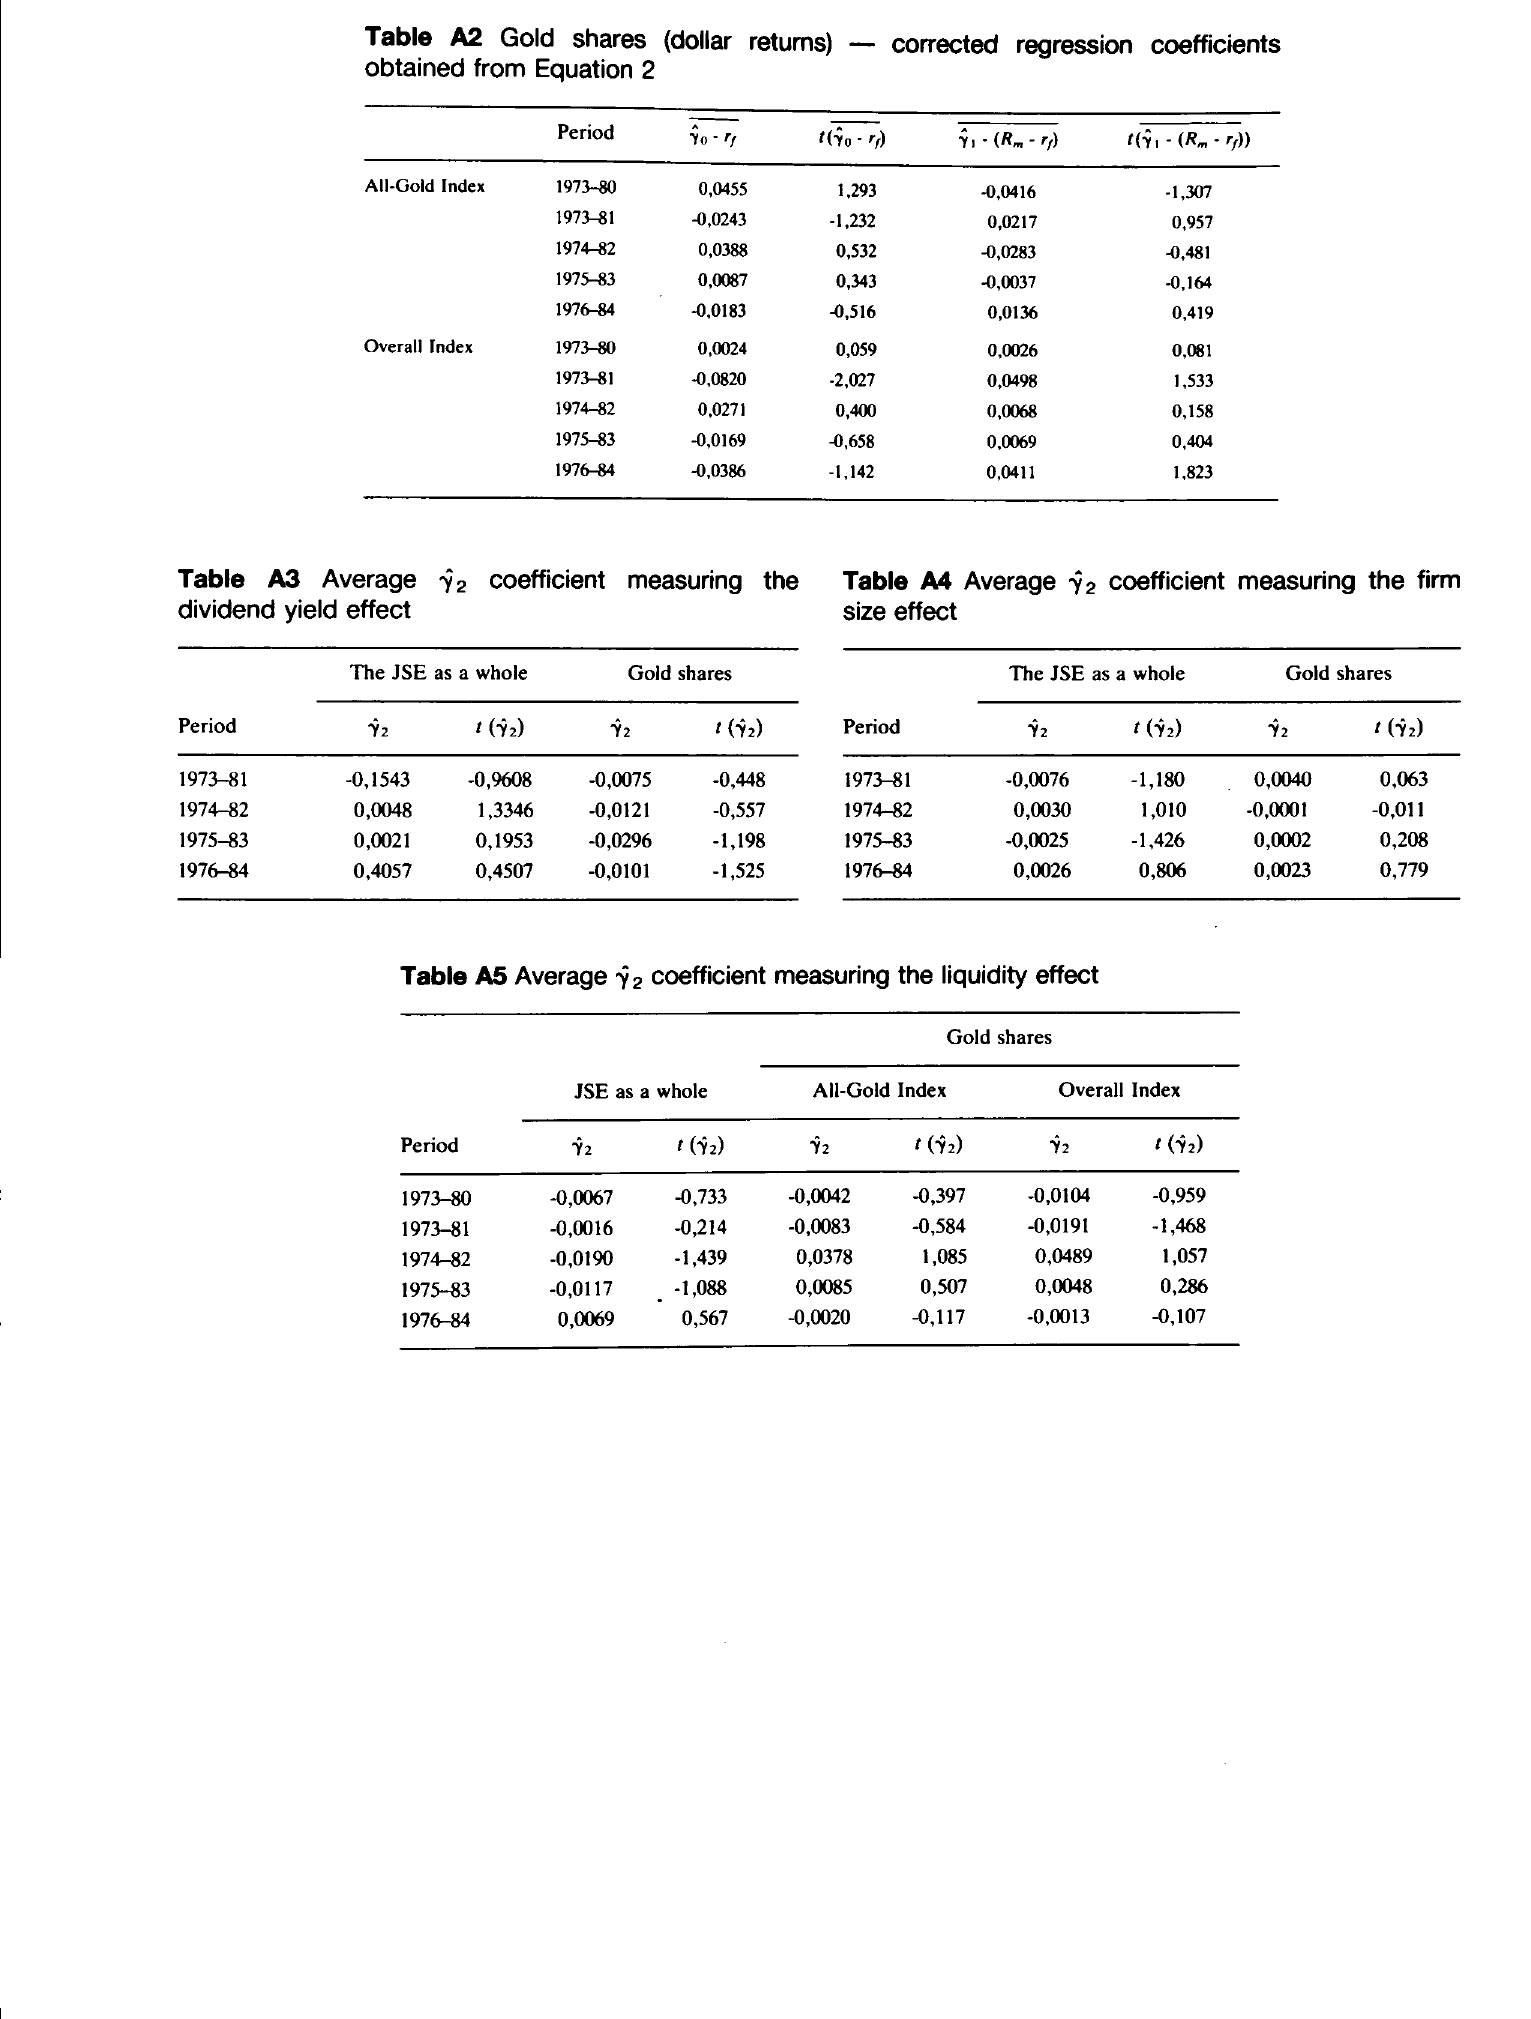
2 coefficient measuring the firm